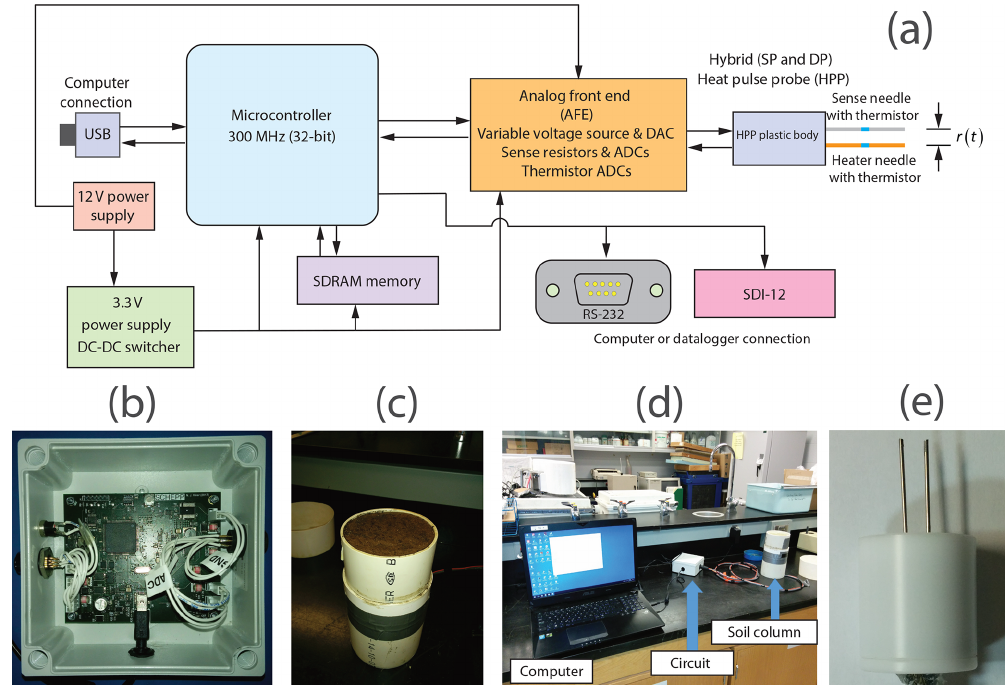
Figure 2. Diagrams showing the system and microcontroller. (a) The circuit operation is controlled by a 32bit microcontroller clocked at 300MHz by a PLL. The microcontroller and associated transceiver circuity implement M2M communications whereby data and system operation can be exchanged between machines using commands sent over USB, RS-232, or SDI-12. The microcontroller acts as a state machine that samples data from the AFE and stores the data in SDRAM where signal processing is conducted. The circuit is powered by a nominal 12V DC supply that is reduced to 3.3V by a DC–DC switcher. The HPP is a hybrid SP and DP design comprised of a heater needle and a sense needle. The effective distance between the needles as a function of time is r(t) . (b) Picture of the circuit. (c) Soil column used in the experiment. (d) Experimental setup. (e) Image of needle probe